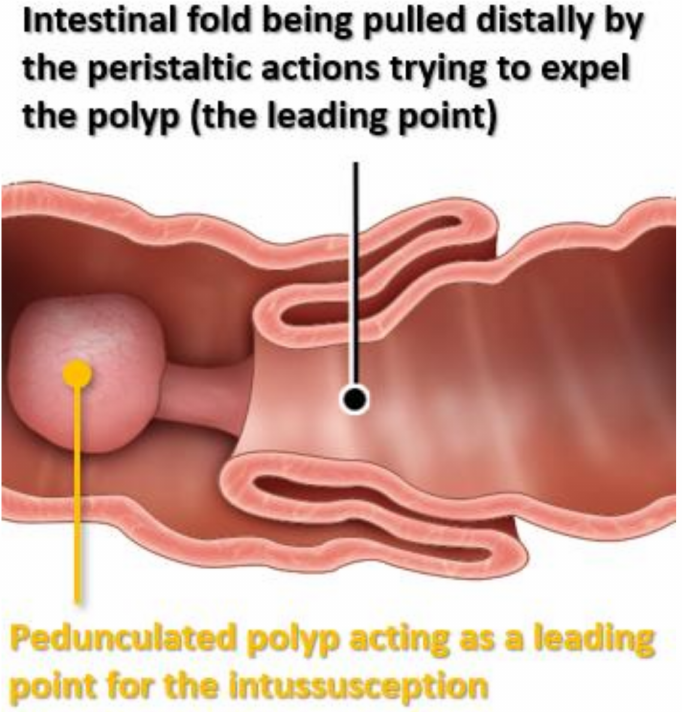
Figure 5. Diagrammatic illustration of PJS GIT polyp as the leading point of intussusception.